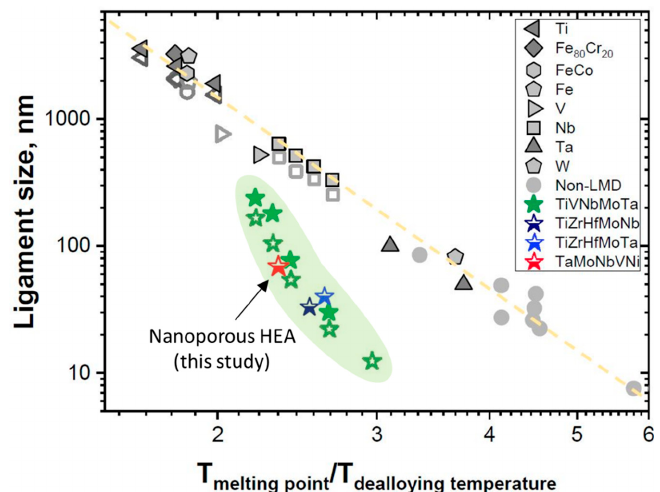
Figure 4. Ligament size versus homologous temperature in conventional nano- and microporous